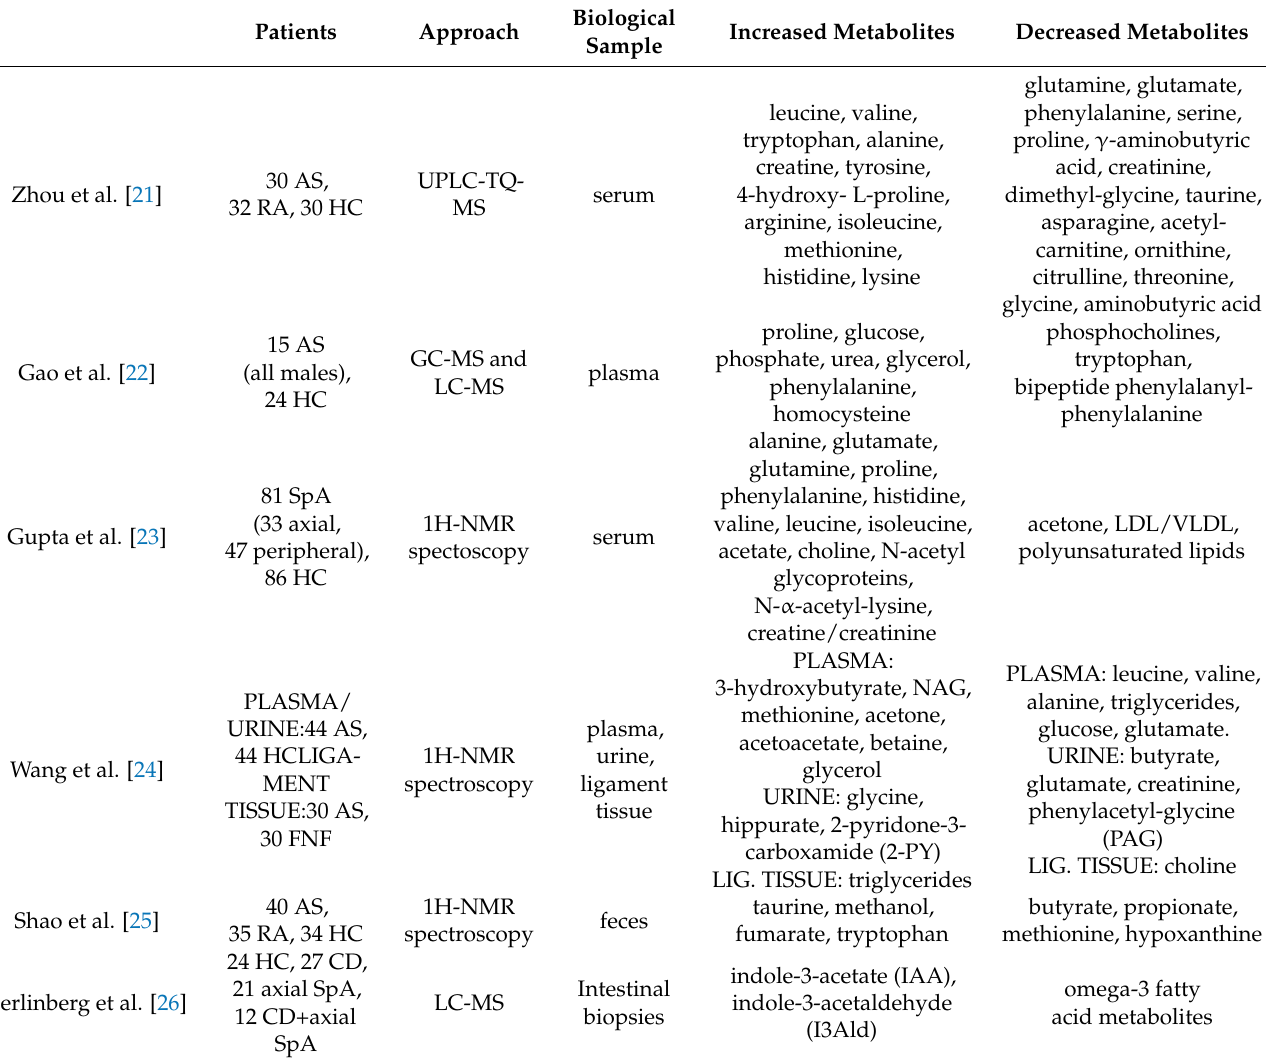
Table 1. Main studies assessing metabolomics in AS